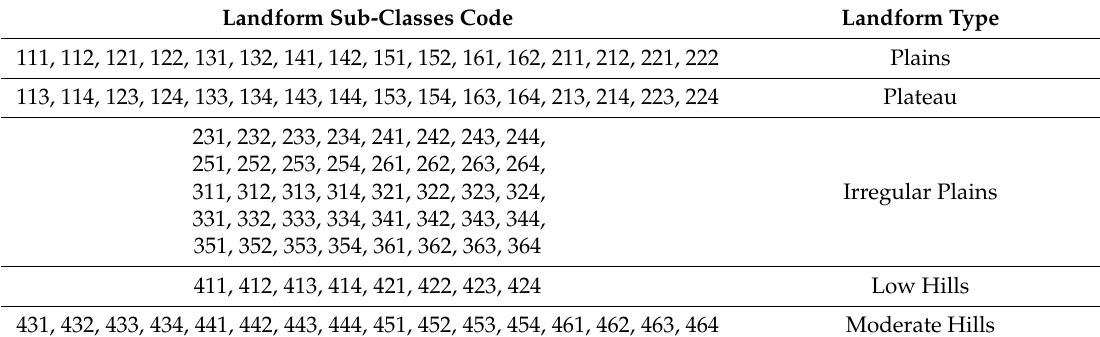
Table 2. Reclassification scheme of the derived landform subclasses to final landform classes.